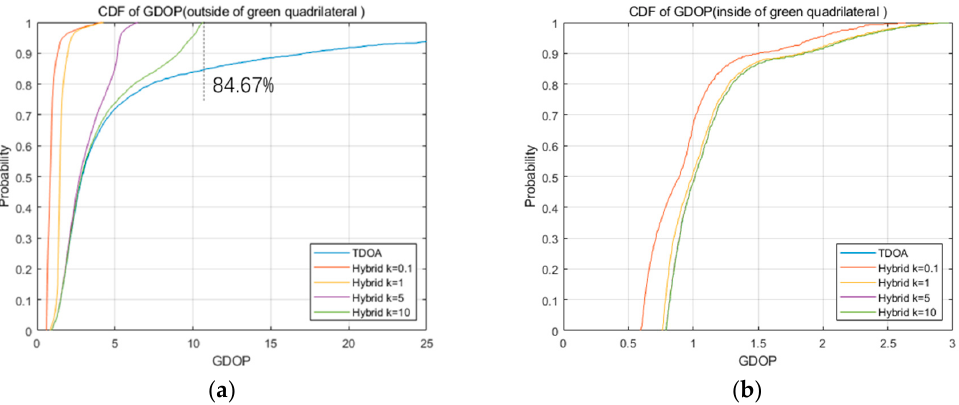
Figure 8. The GDOP CDF of different positioning methods; ( a ) the CDF of GDOPs at points outside the green quadrilateral; ( b ) the CDF of GDOPs at points inside the green quadrilateral, the curves for TDOA and Hybrid k = 10 are identical.